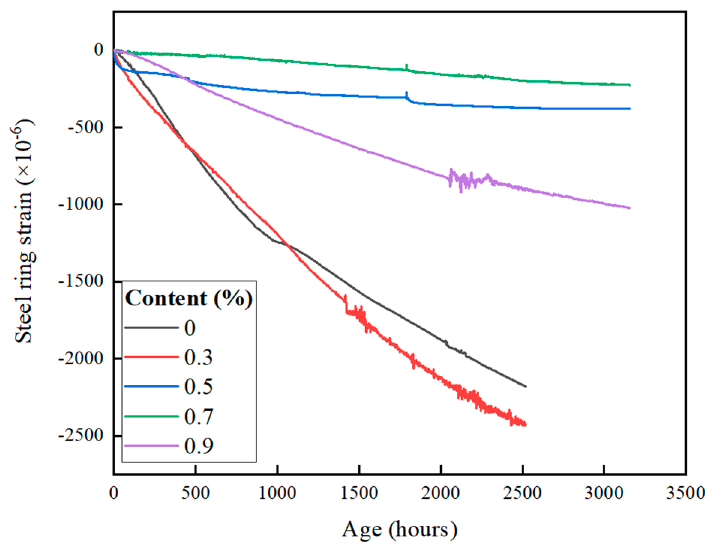
Figure 8. Steel ring strain of GGBFS geopolymers with PAM added.